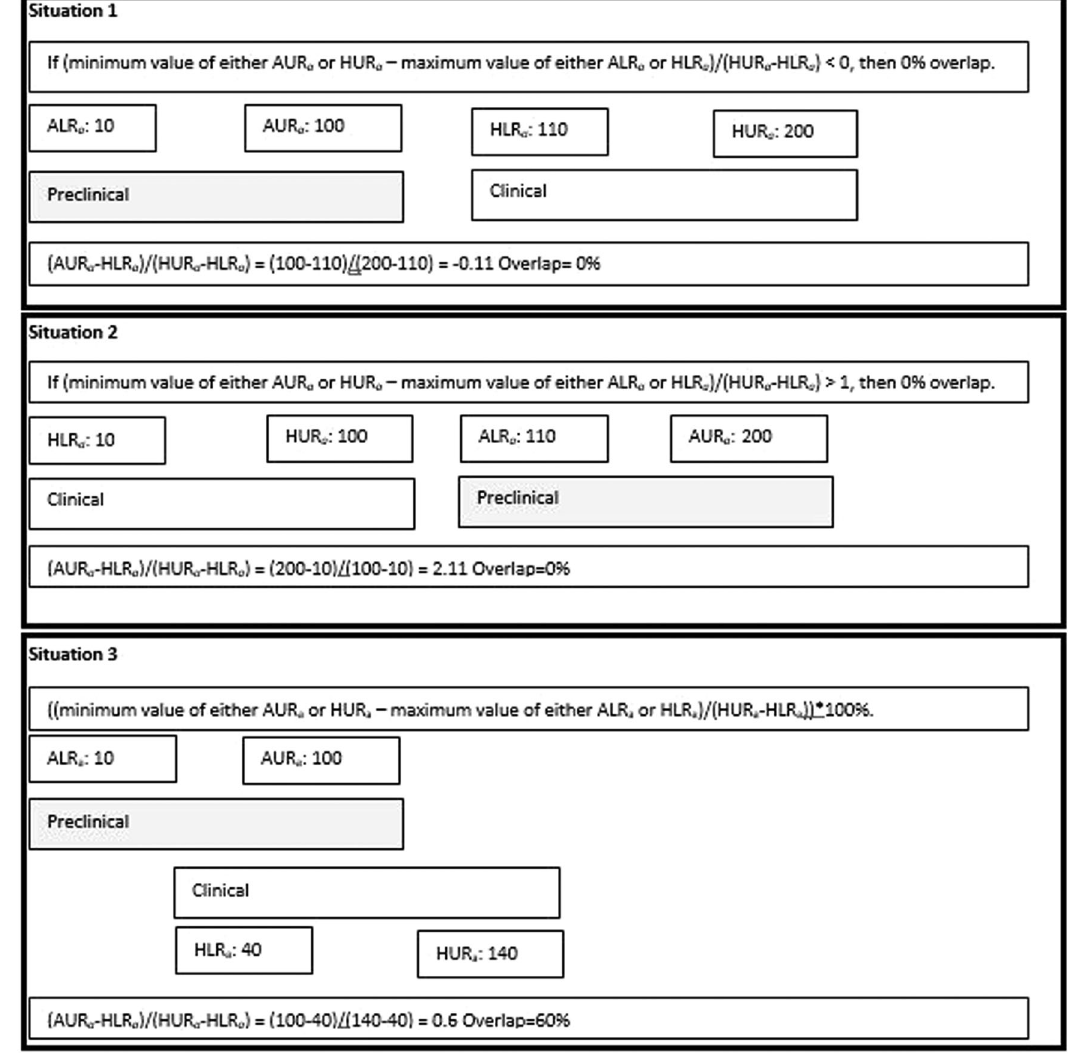
Fig. 1 Overlap calculations. It illustrates how the calculations were